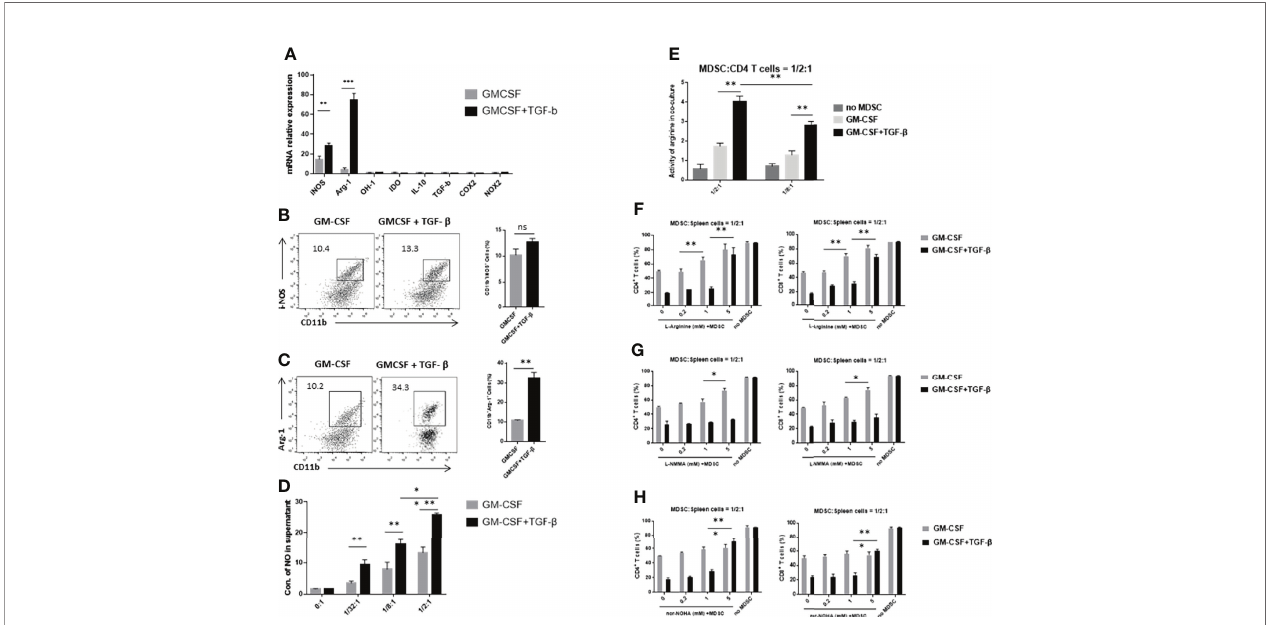
FIGURE 4 | TGF- b + GM-CSF – induced MDSCs exert immunosuppressive functions through the Arg-1 pathway. (A) The mRNA expression levels of iNOS, Arg-1, OH-1, IDO, IL-10, TGF- b , COX2, and NOX2 in GM-CSF and TGF- b + GM-CSF – induced MDSCs were determined by real-time qPCR assay. Typical dot plot of FCM analysis conducted for levels of iNOS (B) and Arg-1 (C) produced by the induced MDSCs. The percentages of CD11b + iNOS + and CD11b + Arg-1 + cells in the GM- CSF – and TGF- b + GM-CSF – induced system have been summarized. (D) GM-CSF – and TGF- b + GM-CSF – induced MDSCs in different concentrations co-cultured with stimulated T cells and the NO levels in the culture medium were detected. (E) The activity of arginine in the co-culture system (MDSC – to – stimulated cell ratio = 1/2:1 and 1/8:1) was detected. Administration of L-arginine (F) , iNOS inhibitor L-NMMA (G) , and Arg-1 inhibitor nor-NOHA (H) , respectively, in co-culture system to analyze the potential inhibitory effects of GM-CSF+TGF- b + GM-CSF – induced MDSCs on the stimulated T-cell proliferation (MDSC – to – stimulated cell ratio = 1/2:1). The data have been shown as mean ± SEM (n = 3) and were analyzed by an unpaired two-tailed Student ’ s t-test, which were collected from three independent experiments. * P < 0.05, ** P < 0.01, and *** P < 0.001 compared between the different